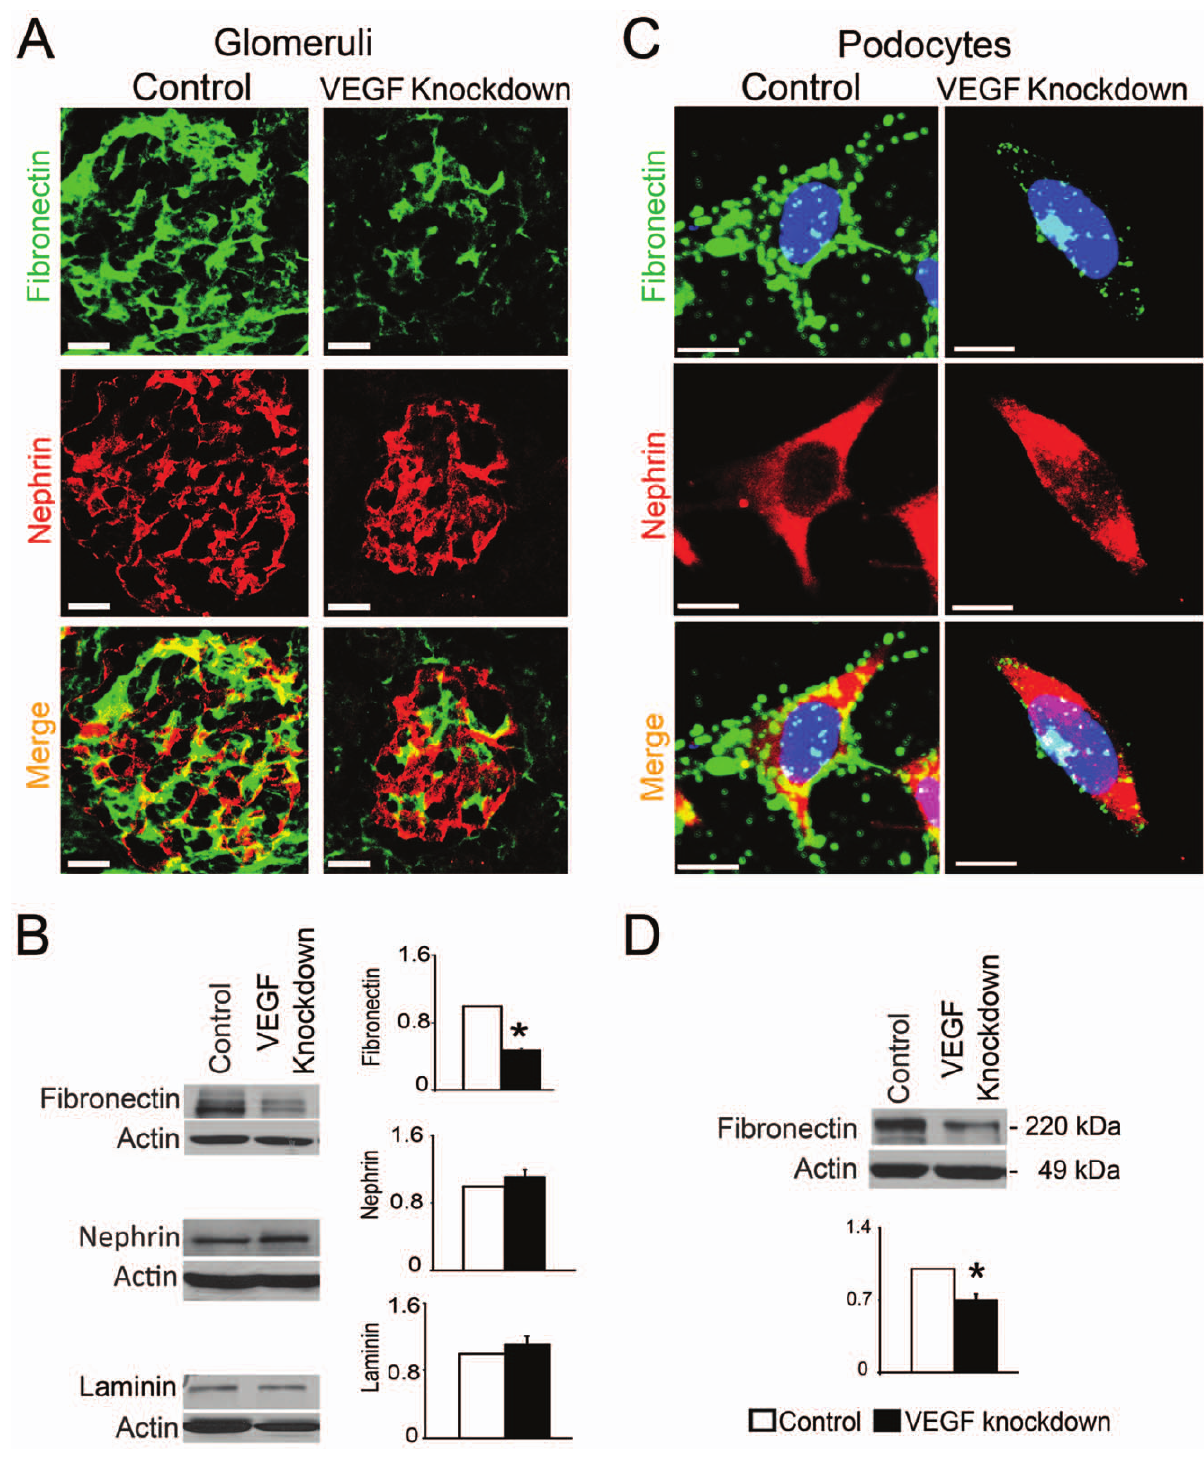
Figure 5. VEGF knockdown downregulates fibronectin expression. (A) IHC: VEGF knockdown glomeruli show marked decrease in immunoreactive fibronectin, while nephrin expression is unchanged. Scale bar=20 m m (B) Representative immunoblots show decreased fibronectin in VEGF knockdown kidney lysate, whereas nephrin and laminin expression levels are similar to controls. (C) ICC: Fibronectin expression decreases in doxycycline-induced VEGF KD podocytes, while nephrin does not change. (D) Representative immunoblot shows fibronectin downregulation in induced VEGF KD podocytes, scale bars=10 m m. In (C) and (D) bar graphs show densitometric analysis, data are expressed as mean 6 SEM fold change in arbitrary units as compared to controls, n $ 3, * indicate P , 0.05 vs. control.